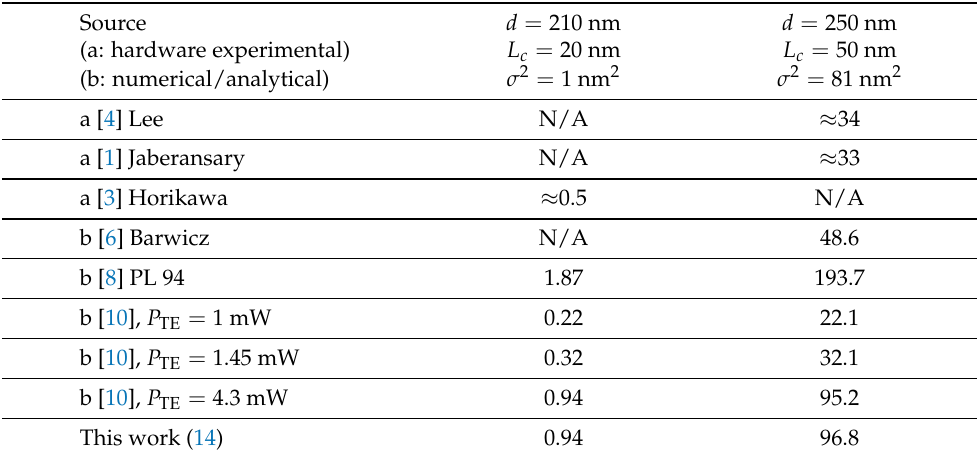
Table 1. α values in